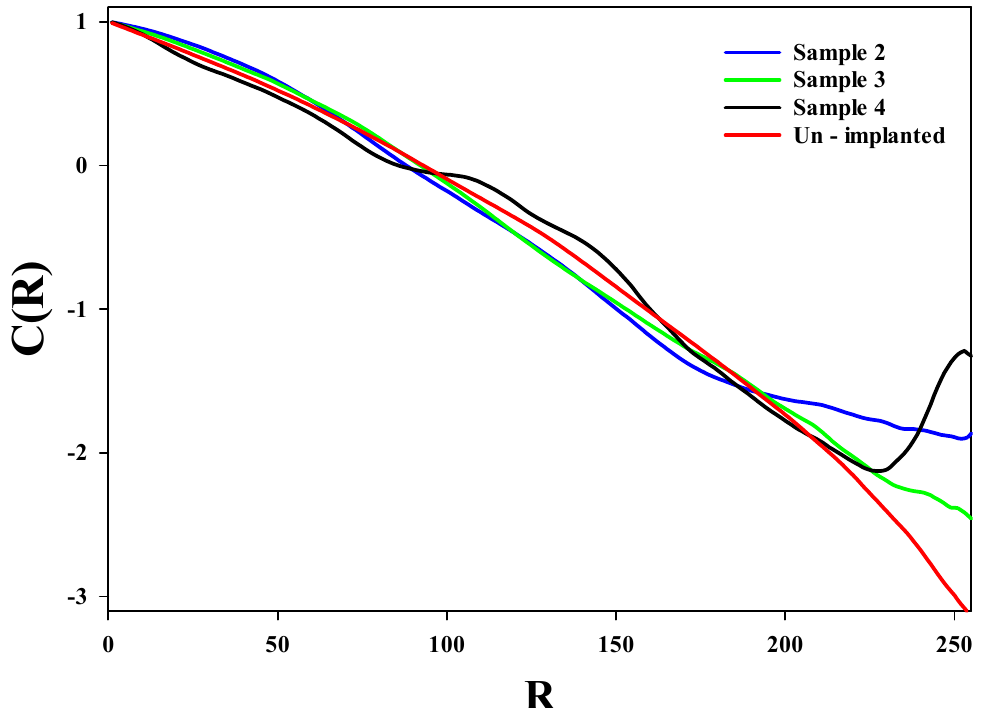
Figure 4. The correlation functions as a separation distance for unimplanted and implanted samples.